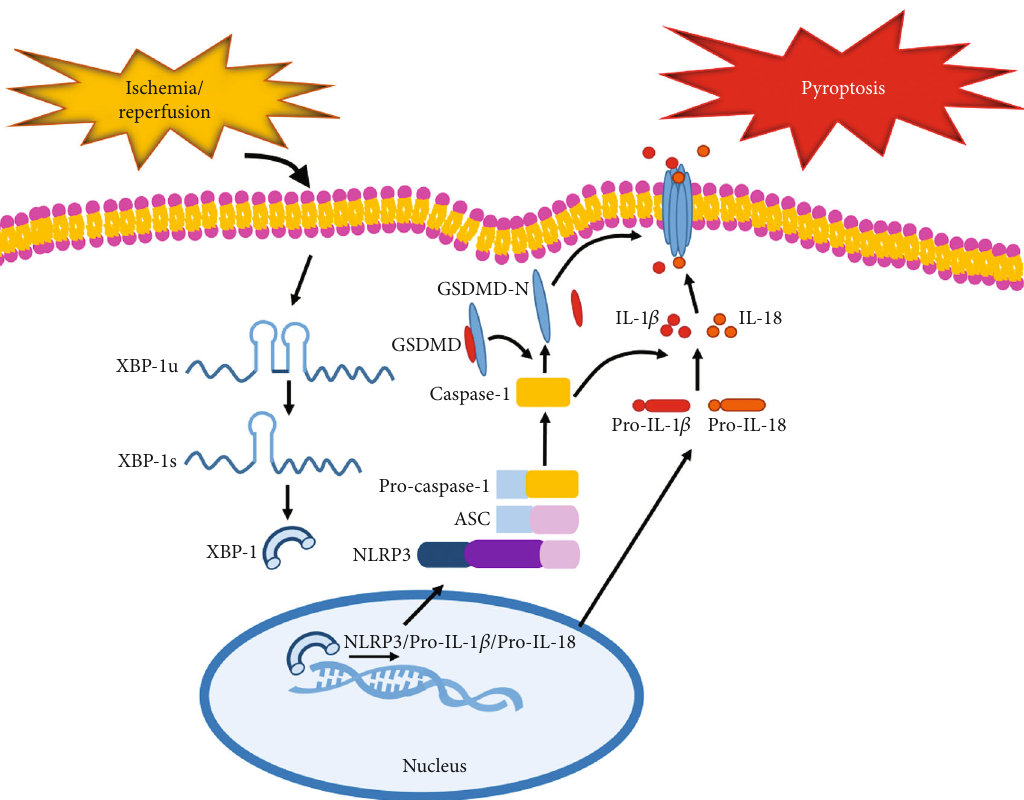
Figure 5: A schematic diagram for the mechanisms of XBP-1 in the regulation of neuronal pyroptosis following cerebral ischemia. The expression of XBP-1 is upregulated after cerebral ischemia/reperfusion. Cerebral ischemia/reperfusion mediates Xbp-1u mRNA splicing to generate the active XBP-1s form. Active XBP-1s promotes NLRP3-ASC/Caspase-1 in fl ammasome assembly, which generates in fl ammatory mediators and cytokines. The triggered Caspase-1 cleaves GSDMD to promote the release of the N-terminal domain, which executes pore formation on the neuronal membrane. The mature forms of IL-1 β and IL-18 that are secreted through these pores are also increased. Downregulated XBP-1 can facilitate an anti-in fl ammatory e ff ect and inhibit pyroptosis. XBP-1: X-box binding protein l splicing; NLRP3: NOD-, LRR-, and pyrin domain-containing 3; ASC: speck-like protein containing a CARD; GSDMD: gasdermin D; GSDMD-N: N-terminal GSDMD domain; IL-1 β : interleukin-1 β ; IL-18: